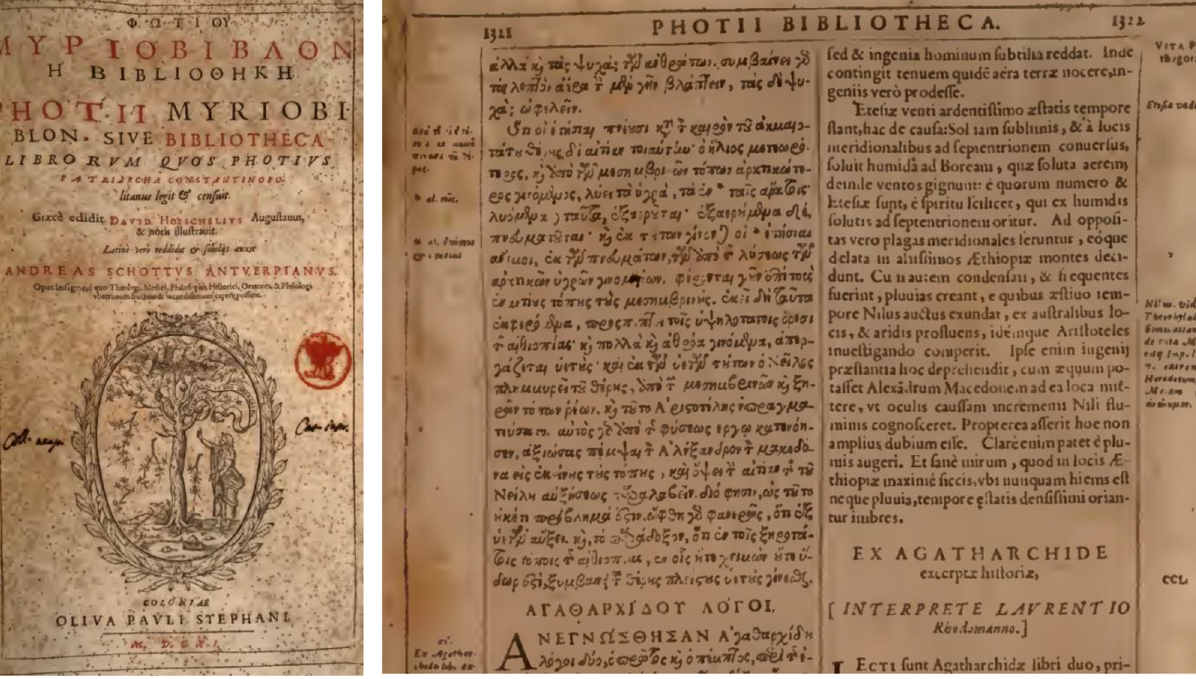
Figure 12. Title page and part of another page from Patriarch Photius’ (Myriobiblon sive Biblioteheca), printed in 1611. The page depicted is that referring to the first scientific expedition in history, ordered by Aristotle and executed by his pupil Alexander the